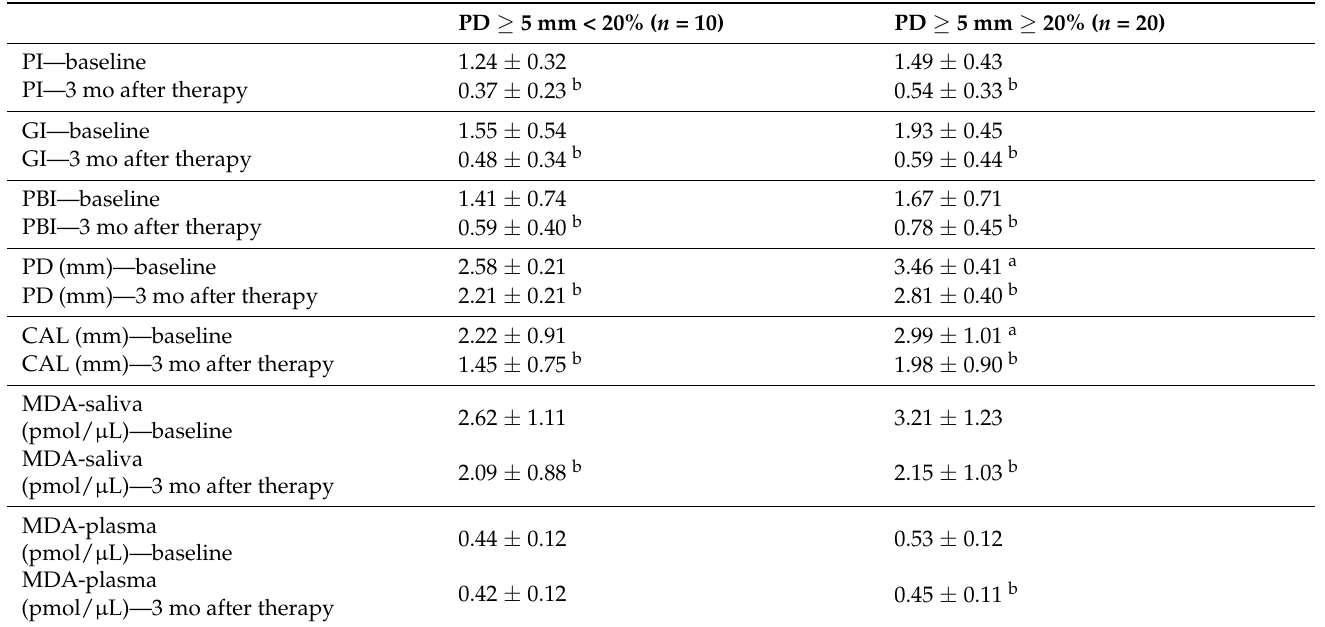
Table 4. Periodontal indices and MDA levels at baseline and three months upon therapy completion in groups with PD ≥ 5 mm < 20% and PD ≥ 5 mm ≥ 20%.